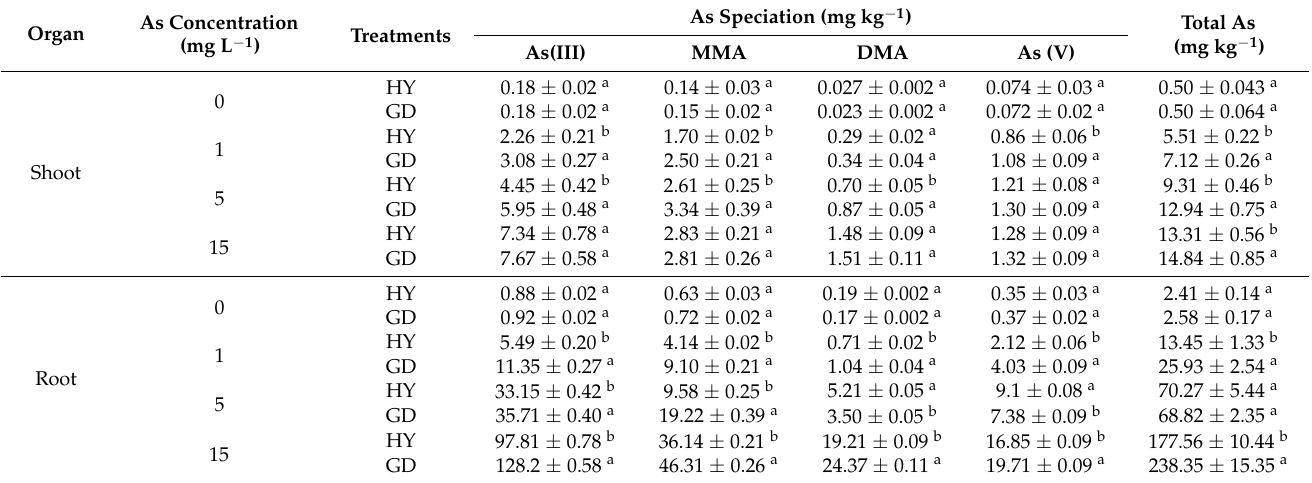
Table 1. As speciation in two Chinese flowering cabbages under different doses of As.